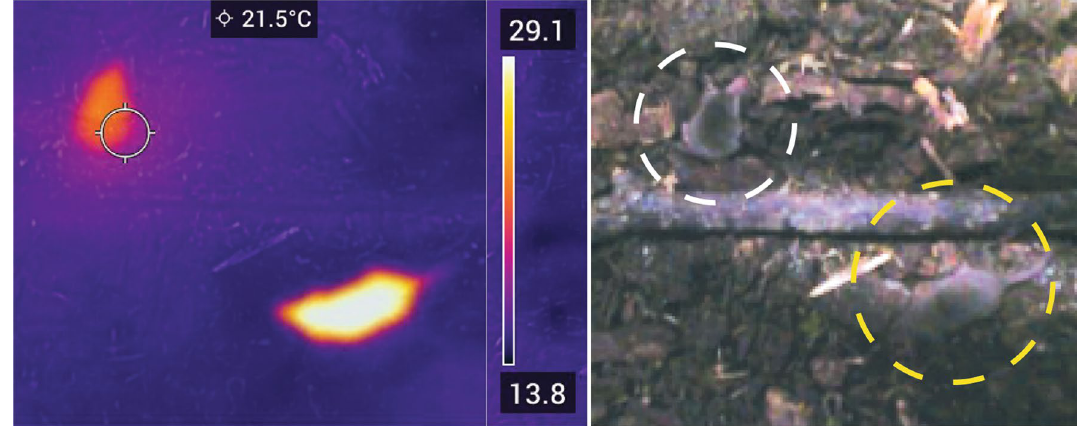
Figure 1. Etruscan shrews readily enter torpor upon fasting. Thermal image and color photograph of a normally active shrew (yellow dashed circle) and a torpid shrew (white dashed circle). The shrew in torpor shows a surface body temperature of approximately 22 °C, as compared to ~ 29 °C for the non-torpid